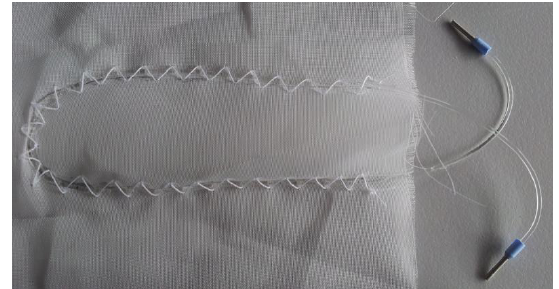
Figure 1. Picture illustrating the integration of the fibre into the textile to form the sensing setup, herein called “half